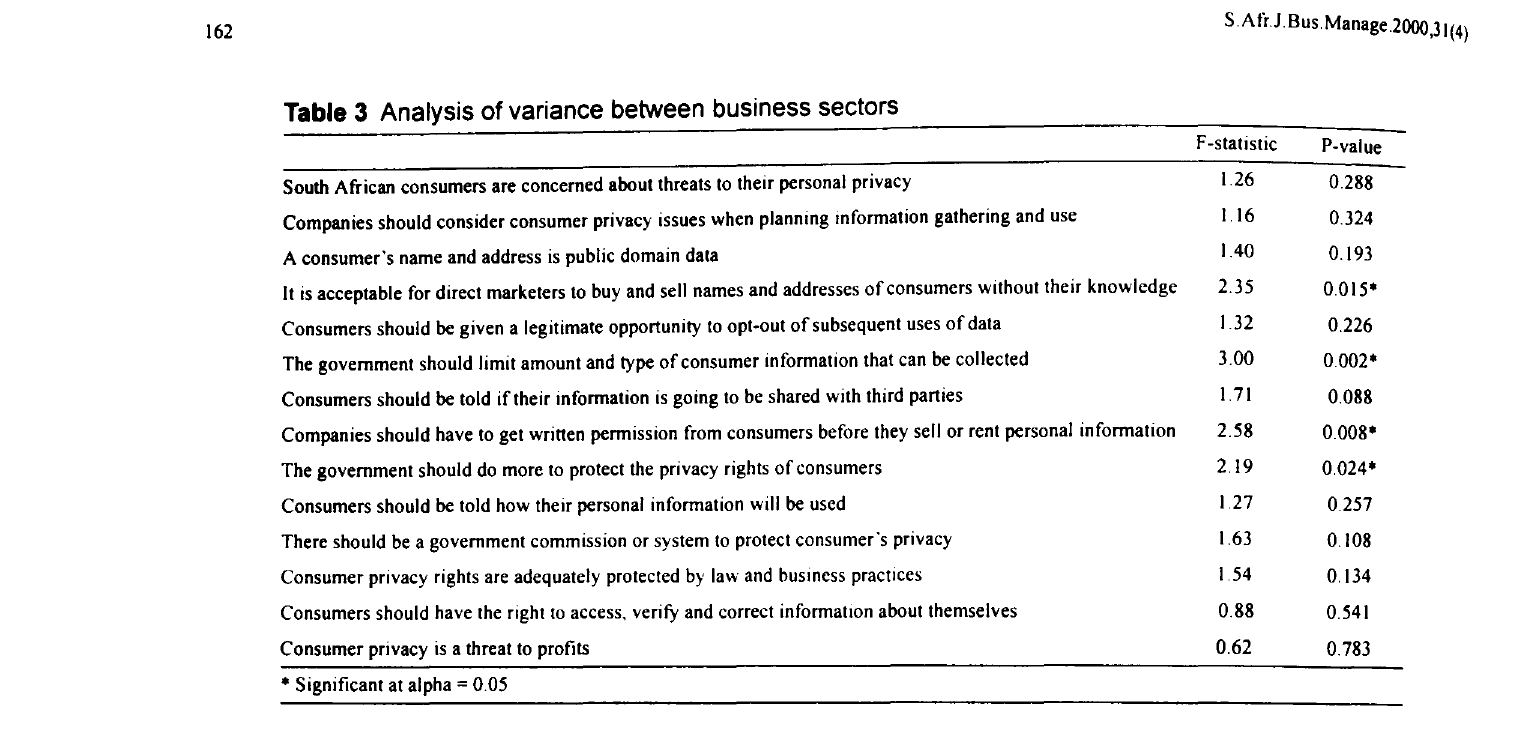
Table 3 Analysis of variance between business